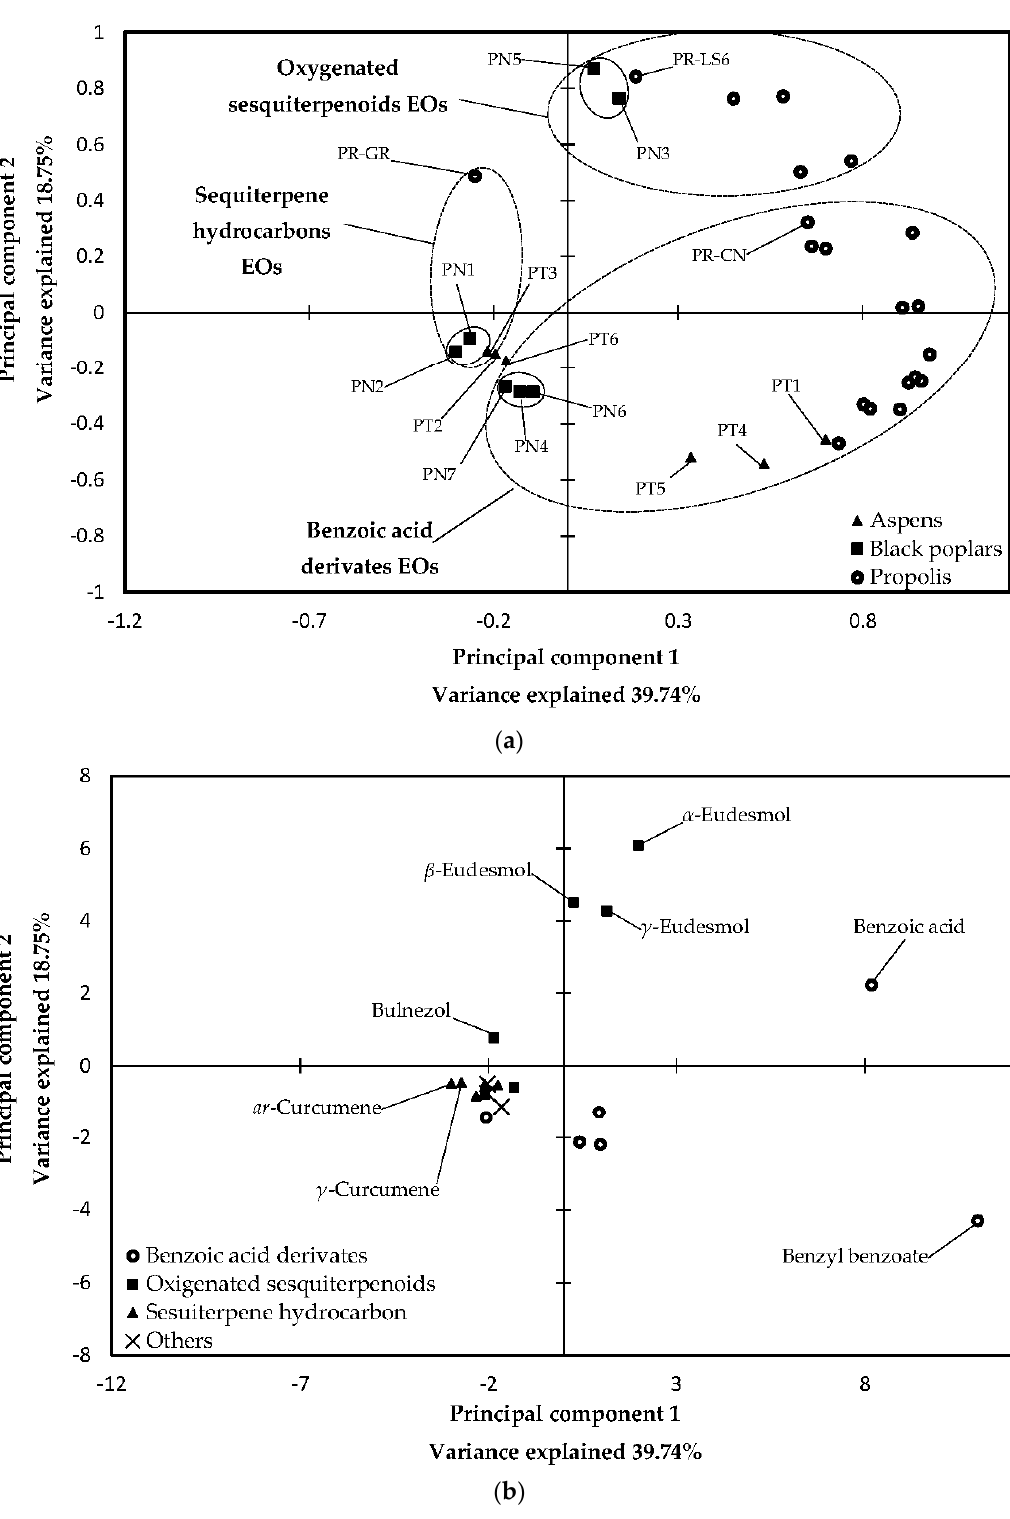
Figure 2. PCA of essential oils: score plot ( a ); and load plot ( b ).